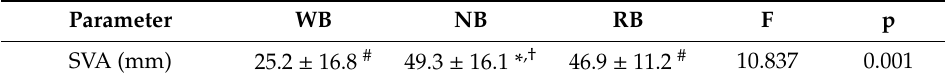
Table 4. Comparison of sagittal vertical axis in each